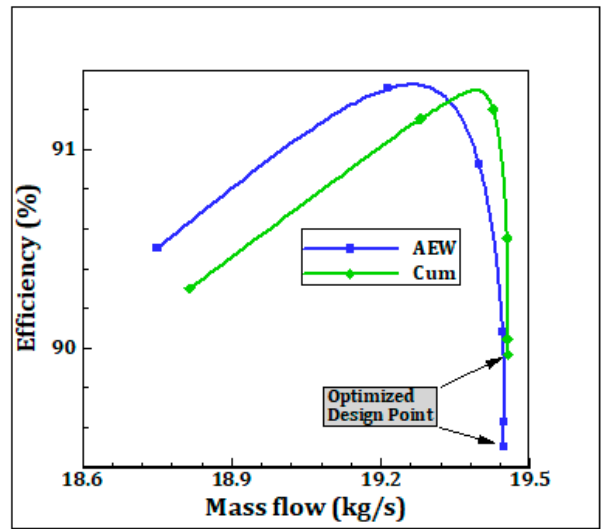
Figure 18. Predicted stage efficiency with the axisymmetric and non-axisymmetric stator and rotor hub at design and off-design conditions.